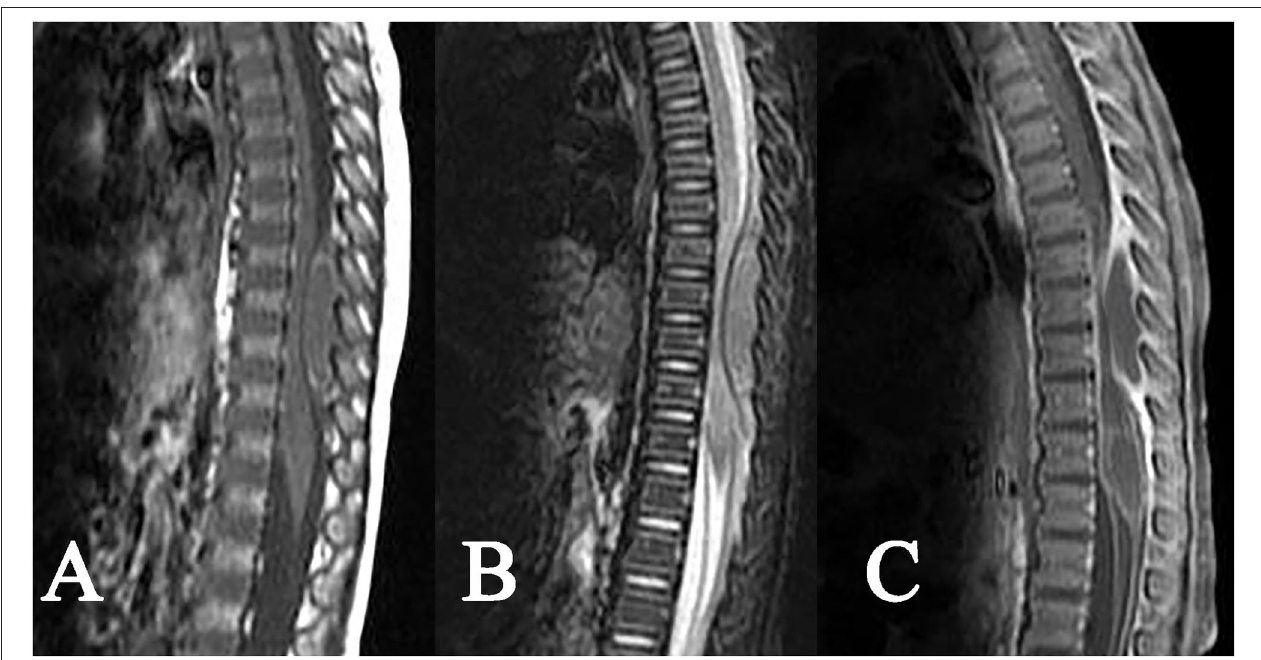
FIGURE 5 | Epidural tuberculoma of the thoracic spinal cord. A fusiform lesion: (A) slight hypointense on T1WI, (B) isointense on T2WI, (C) rim enhancement after contrast enhancement, showing remarkable compression of the adjacent spinal cord and dural sac.